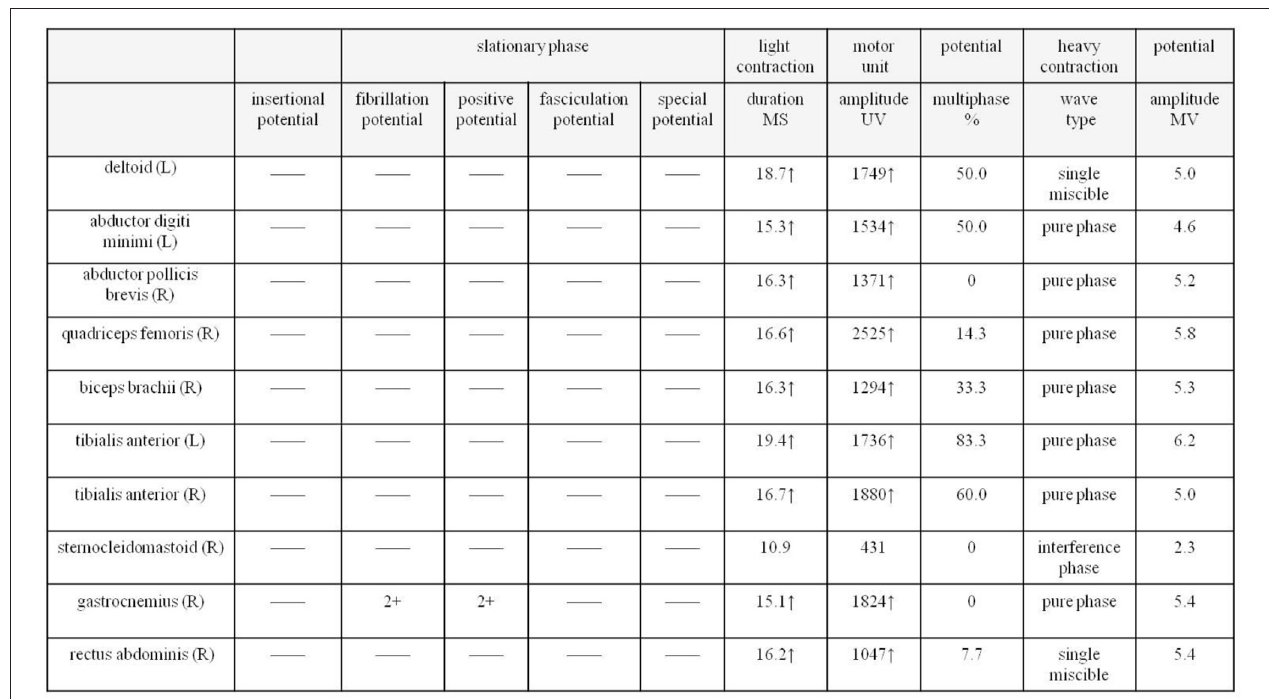
FIGURE 3 | EMG of the patient shows extensive neurogenic damage with chronic changes involving the cervical, thoracic and lumbosacral innervated muscles. EMG, electromyography.